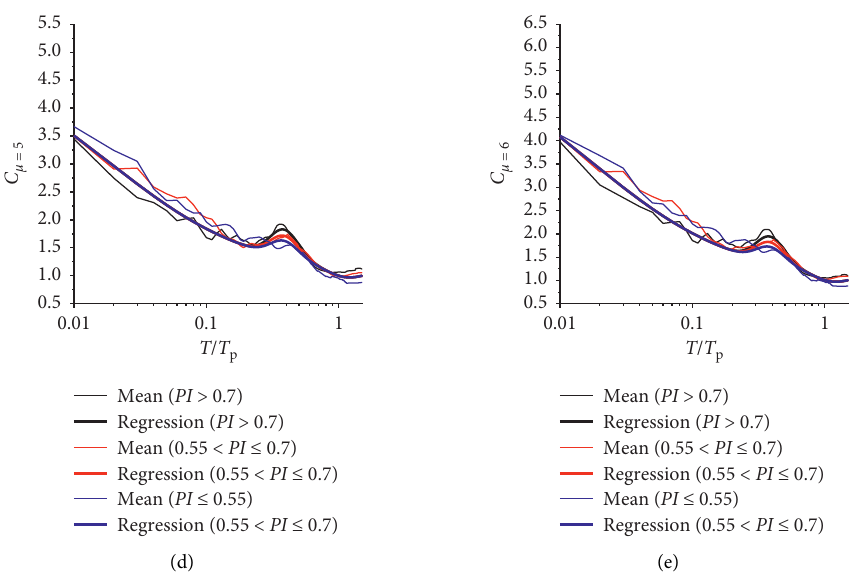
Figure 14: Comparison of the regression results to the mean inelastic displacement ratios for (a) µ � 2, (b) µ � 3, (c) µ � 4, (d) µ � 5, and (e) µ � 6.